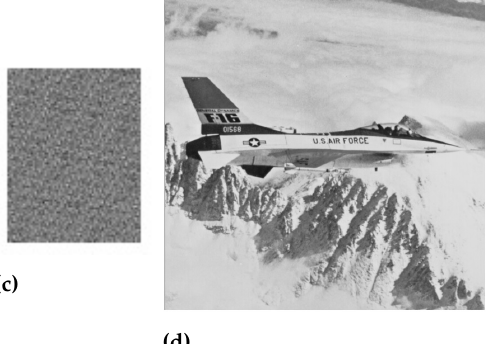
Figure 6. ( a ) Original jet image, ( b ) Watermark image, ( c ) Scrambled image, and ( d ) Watermarked jet image.